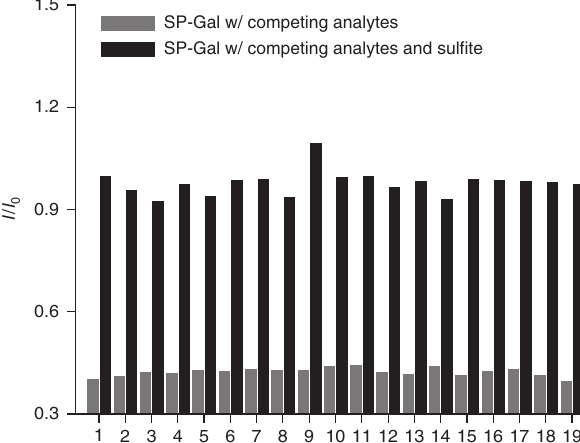
Fig. 5 Biospeci fi city of photochromic fl uorescent glycoprobe. The fl uorescence change of MR-Gal (10 – 5 M) with a range of competing analytes (10 − 3 M) and the mixture of the analytes (10 − 3 M) with sul fi te (5 × 10 − 5 M) in phosphate buffered saline (PBS, 0.01 M, 1% DMSO, pH 7.4) at 298 K (excitation wavelength: 450 nm), where I 0 and I are the fl uorescence of the initial spiropyran state and that of the UV-activated merocyanine state, respectively. Competing analytes 1 – 19: 1: Blank (probe alone), 2: F − ; 3: Cl − ; 4: Br − ; 5: I − ; 6: NO 3 − ; 7: NO 2 − ; 8: CH 3 COO − ; 9: HCO 3 − ; 10: SO 4 2 − ; 11: S 2 O 3 2 − ; 12: PO 4 3 − ; 13: CO 3 2 − ; 14: Cys; 15: Hcy; 16: GSH; 17: HPO 4 2 − ; 18: H 2 PO 4 − ; 19: N 3 . We note that the physiologic concentration of common thiols and nucleophiles such as Hcy, Cys is in the range of 10 – 200 μ M 49 – 51 , which is well-below the concentration used in this